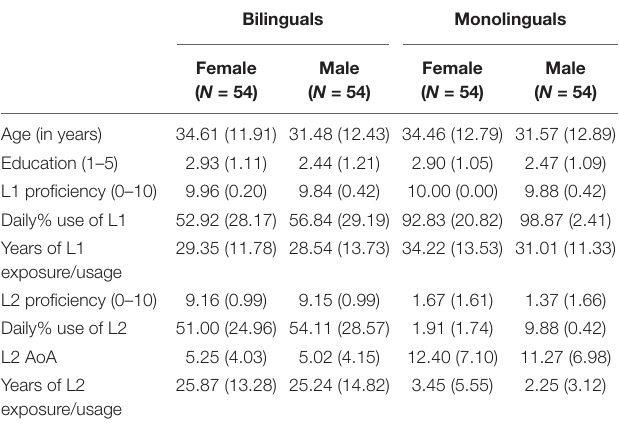
TABLE 1 | Mean values of participant characteristics (SDs in